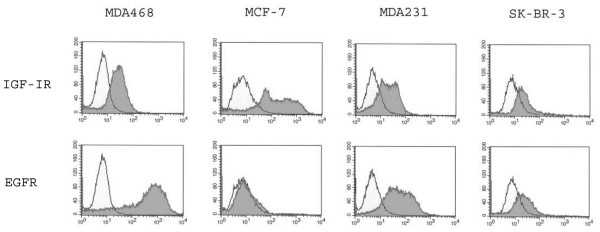
Surface expression of IGF-1R and EGFR in human breast cancer cell lines. Untreated cells were stained with phycoerythrin-conjugated anti-IGF-1R (insulin like growth factor-1 receptor) or with fluorescein-isothiocyanate-conjugated anti-EGFR (anti-epidermal growth factor receptor) antibody. Shaded peaks show flow cytometry analysis of the number of insulin-like growth factor 1 (top row) and epidermal growth factor (bottom row) receptors on the surface of MDA468, MCF-7, MDA231, and SK-BR-3 human breast cancer cells. Outlined peak represents isotype control (normal mouse IgG1). Counts indicate number of events.